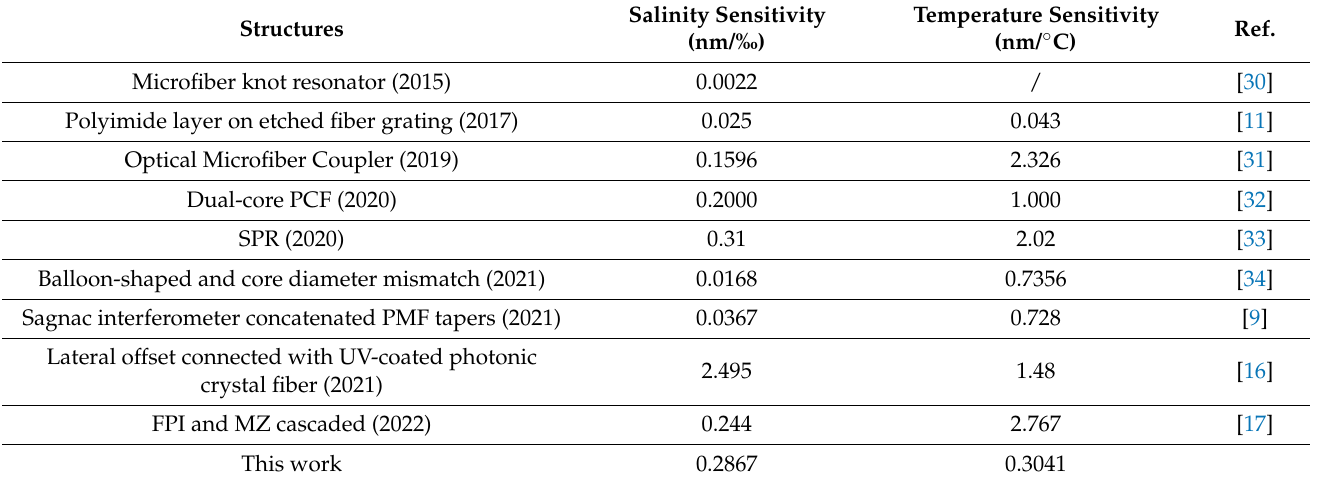
Table 3. Comparison of experimental sensitivities of different structures for salinity and temperature